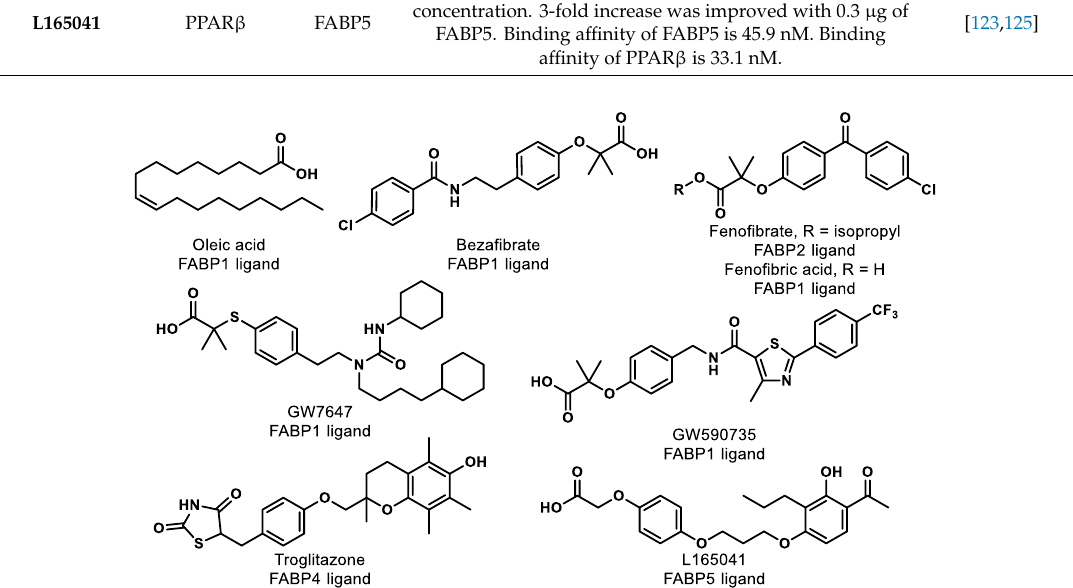
Figure 8. Compounds listed in Table 2.